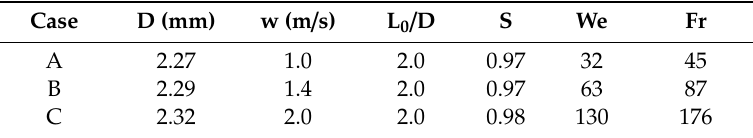
Table 1. Investigated